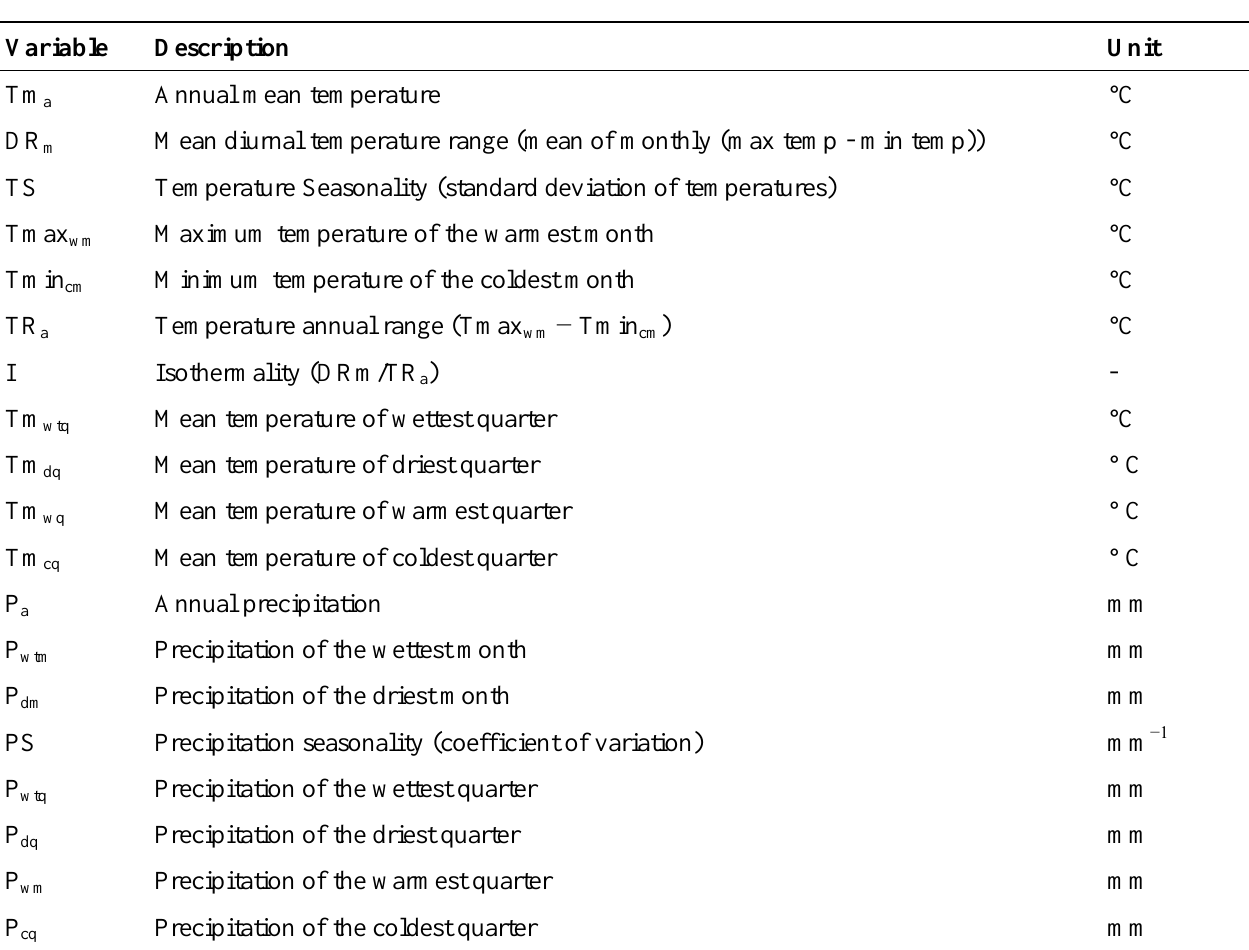
Table 1. Bioclimatic variables used to describe the climatic variation across counties in the two states of North Carolina and South